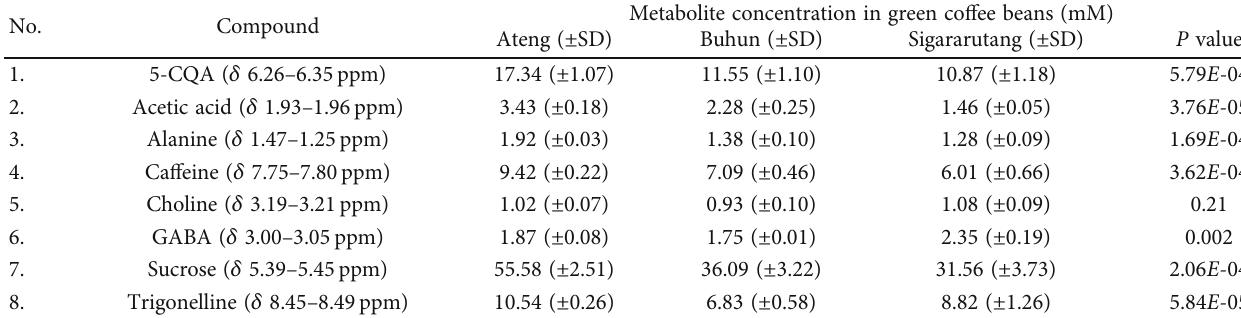
Table 2: Concentrations of some identi fi ed metabolites determined by quantitative 1 H NMR